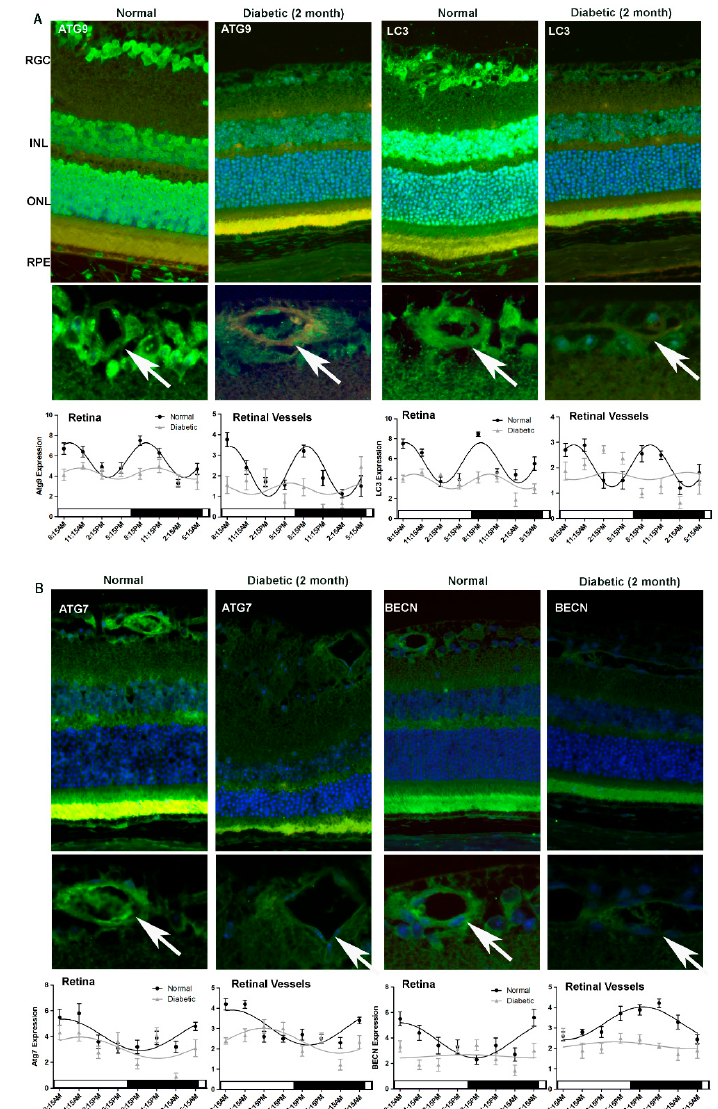
Figure 5. Impairment of diurnal rhythmicity of autophagy in T1D mice with two-months duration of diabetes. Retinas were collected from C57Bl / 6J mice with two-months duration of T1D and age-matched control mice. Immunostaining and intensity analyses of retina and retinal vasculature demonstrated a dramatic loss of oscillatory amplitude of autophagic protein expression in the diabetic animals compared to normal mice ( A , B ). Autophagy protein expression is green, TRITC agglutinin for vessels red and DAPI nuclear staining blue. The arrows indicate autophagy protein localization to retinal vessels. RGC, retina ganglion cell; INL, inner nuclear layer; OPL, outer plexiform layer; ONL, outer nuclear layer; RPE, retinal pigment epithelium. Loss and phase-shifting of diurnal rhythmicity in diabetic retinopathy is demonstrated in single cosine plots, with ordinary least square fitted ( p < 0.01, n = 10). All animals were maintained in a standard 12/12-h light/dark phase with lights ON at 6:00AM and lights OFF at 6:00PM. The error bars in the circadian plots represent the mean+SEM and diurnal oscillation had a p -value less than 0.05.